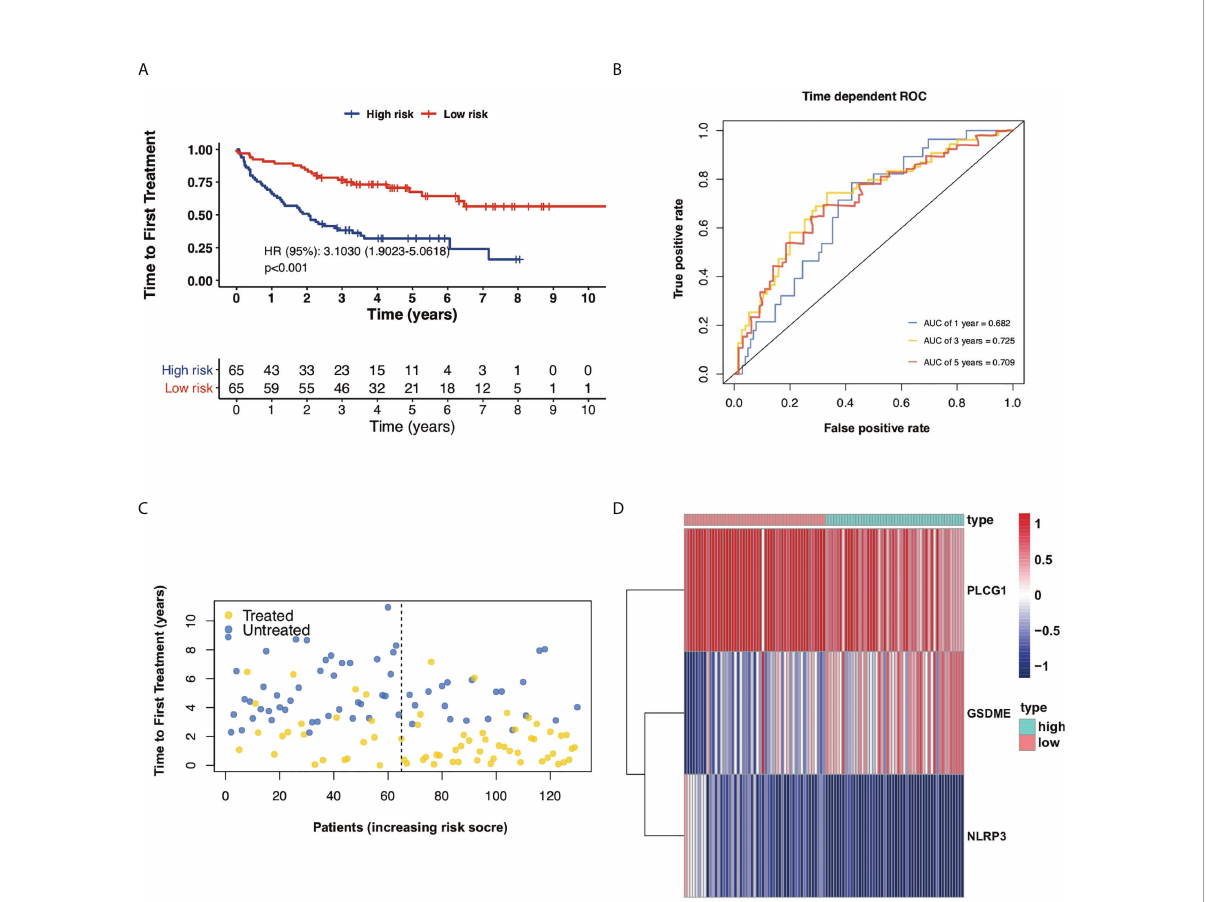
FIGURE 4 Validation of the prognostic model in respect of TTFT. (A) Kaplan – Meier plot showed TTFT of 130 CLL samples between high- and low-risk subgroups. (B) ROC curves showed the predictive ef fi ciency of the risk model in 130 CLL samples in terms of 1-year, 3-year, and 5-year TTFT. (C) Treatment status of 130 CLL samples. (D) Heatmap for expression of screened pyroptosis-related genes between high-risk and low-risk subgroups in 130 CLL samples.